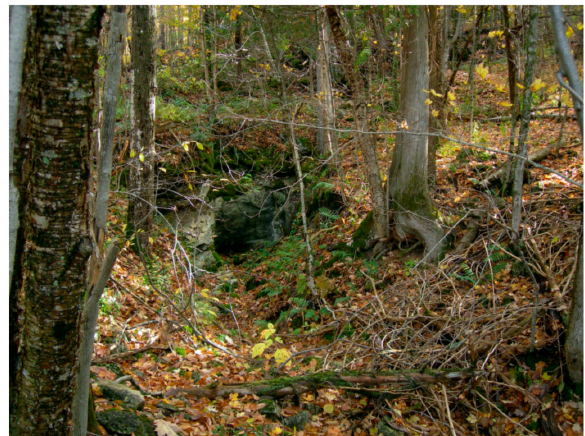
Figure 3. Dodge mine looking north to the wall of the east–west cross cut as it appeared in September, 2008.